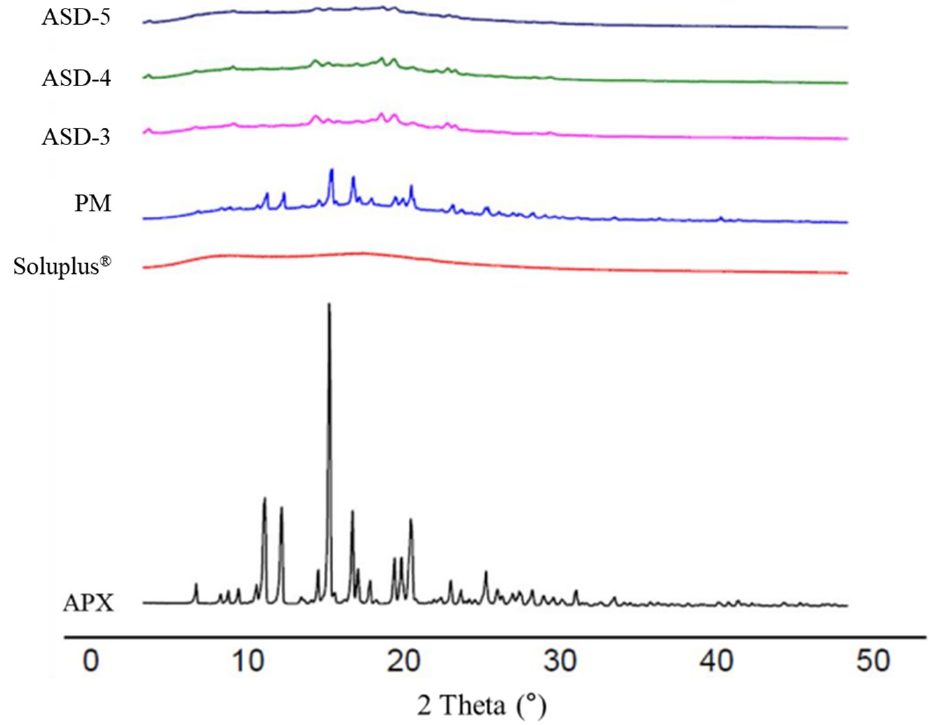
® , PM, and ASD-3, -4, -5.